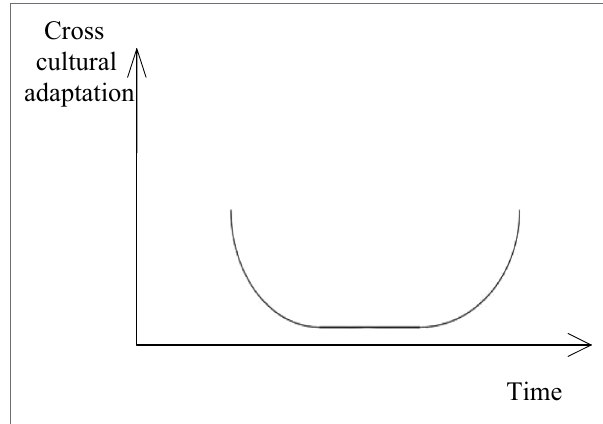
FIGURE 1 | U-shaped emotional curve.